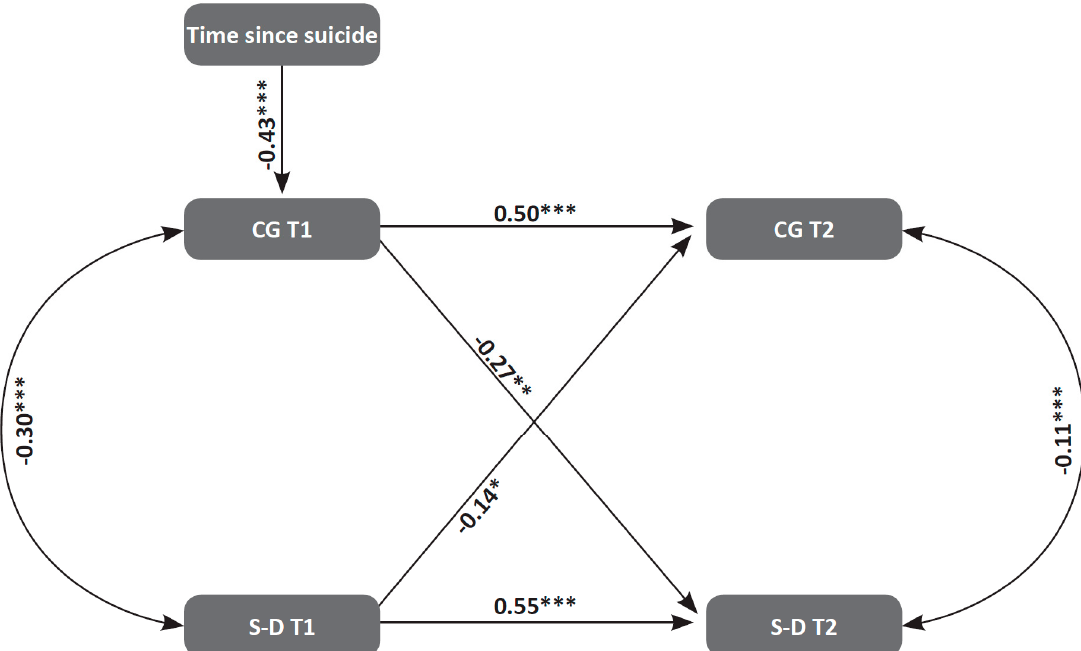
Figure 3. A serial mediational integrated model for CF T2 by S-D and time since suicide among suicide survivors. The rectangles indicate measured variables and the small circles reflect residuals (e). The numbers above or near endogenous variables represent the amount of variance explained (R²). The unidirectional arrows depict hypothesized directional links. Standardized maximum likelihood parameters were used. ( N = 156). CG = complicated grief. S-D = self-disclosure. Note: * p < 0.05; *** p < 0.001